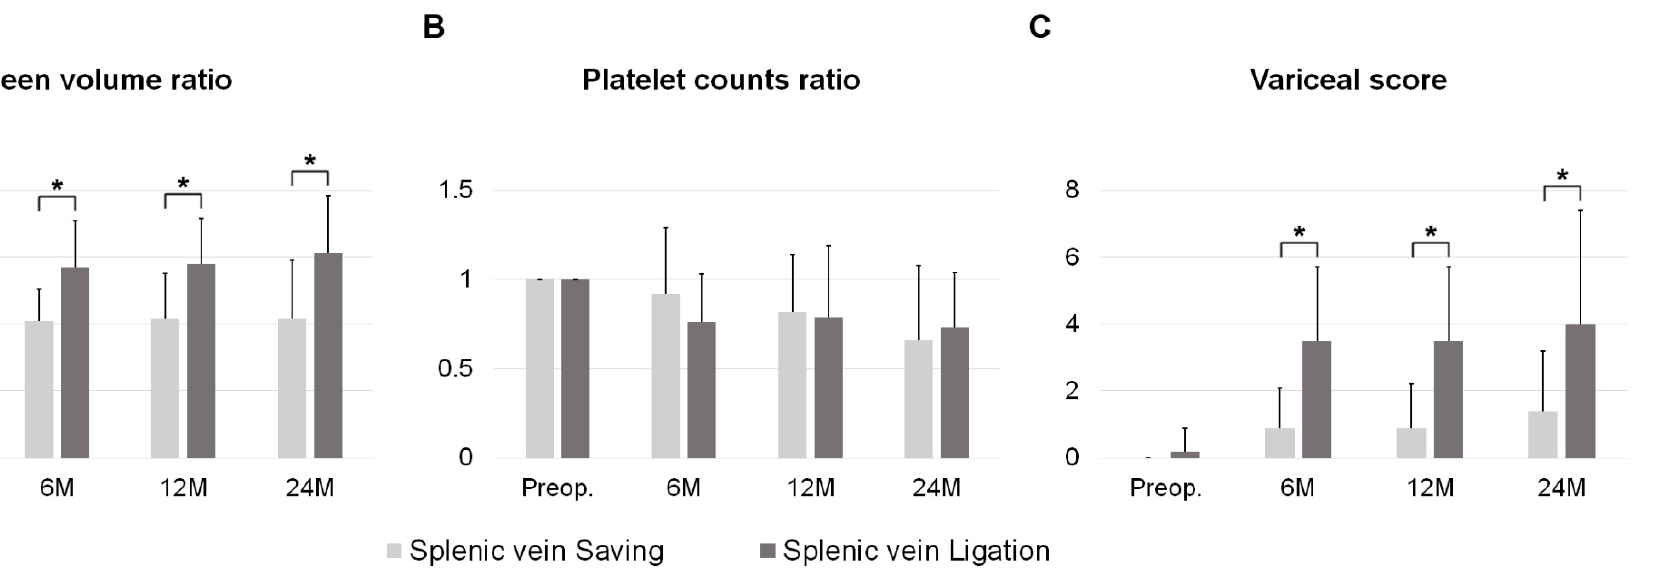
Figure 1. Pre- and postoperative changes in variceal-related parameters: ( A ) spleen volume ratio, ( B ) platelet count ratio, and ( C ) variceal score (* p < 0.05).